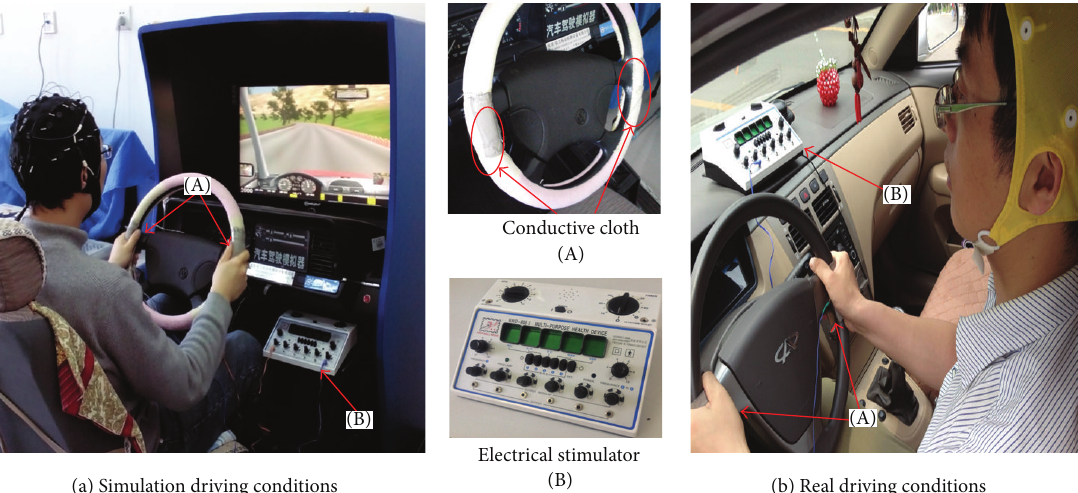
Figure 1: Experimental